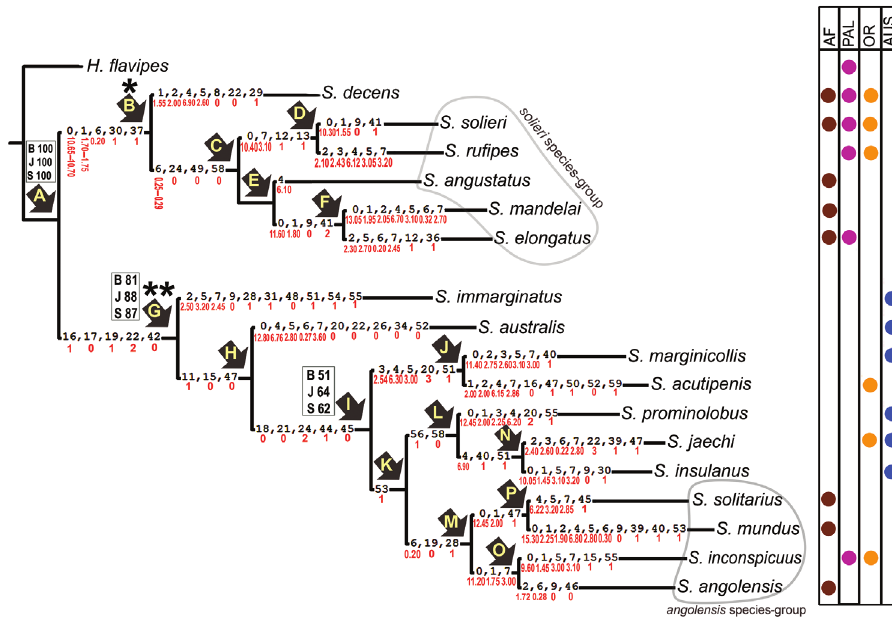
Figure 22. Single most parsimonious tree (146.130 steps) based on 60 morphological characters (52 discrete and 8 continuous). Bootstrap (B), Jackknife (J) and Symmetric (S) support values over 50% are mentioned above the corresponding branches, respectively. The arrows with capital letters indicate the clades. Synapo- morphies are shown on the branches, and character states in red. Table on the right shows distribution of the species by region (AF = Afrotropical, PAL = Palaearctic, OR = Oriental, AUS = Australian). The two major clades are marked as (*) and (**) indicating Sternolophus s. str. and Neosternolophus respectively . Species groups angolensis and solieri (see Nasserzadeh and Komarek 2017) are shown in closed irregular